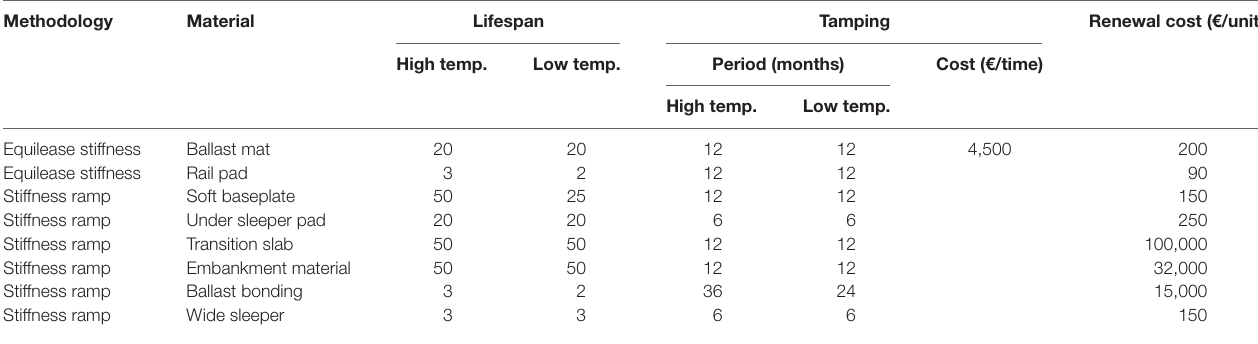
TaBle 4 | Lifespan and maintenance in case of extreme temperature.